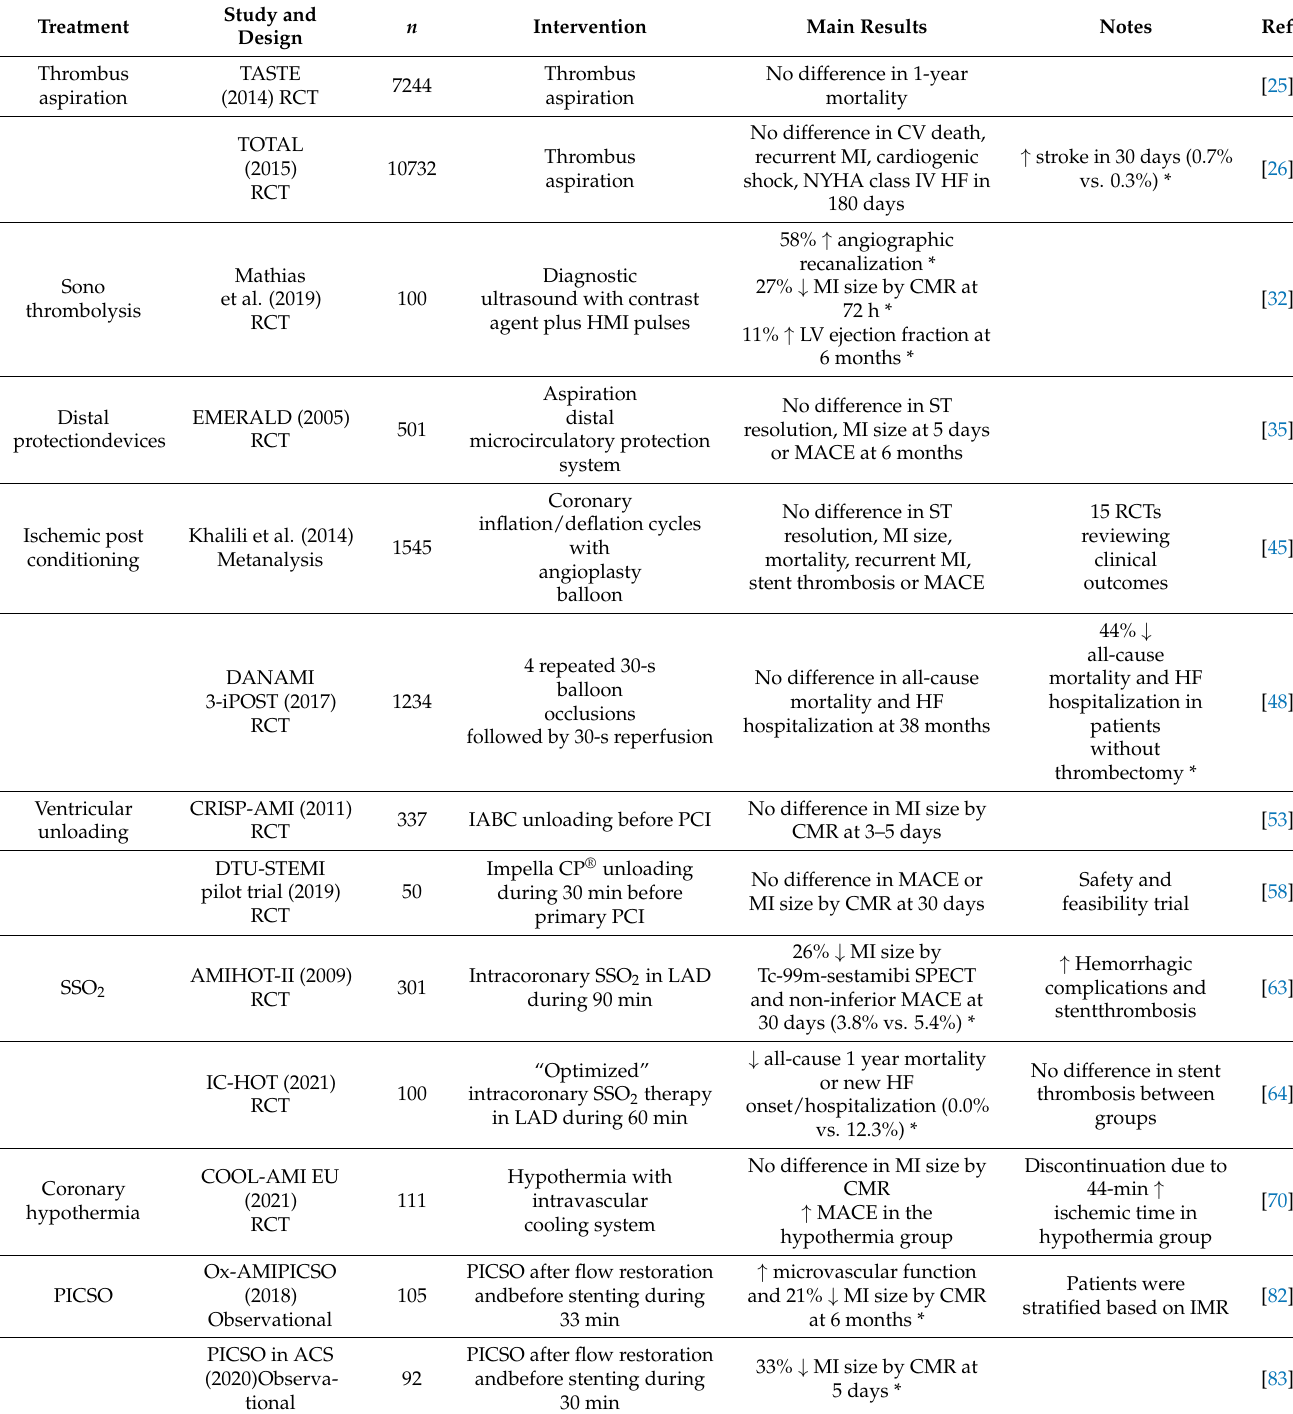
Table 1. Summary of key studies of novel interventional treatments in STEMI